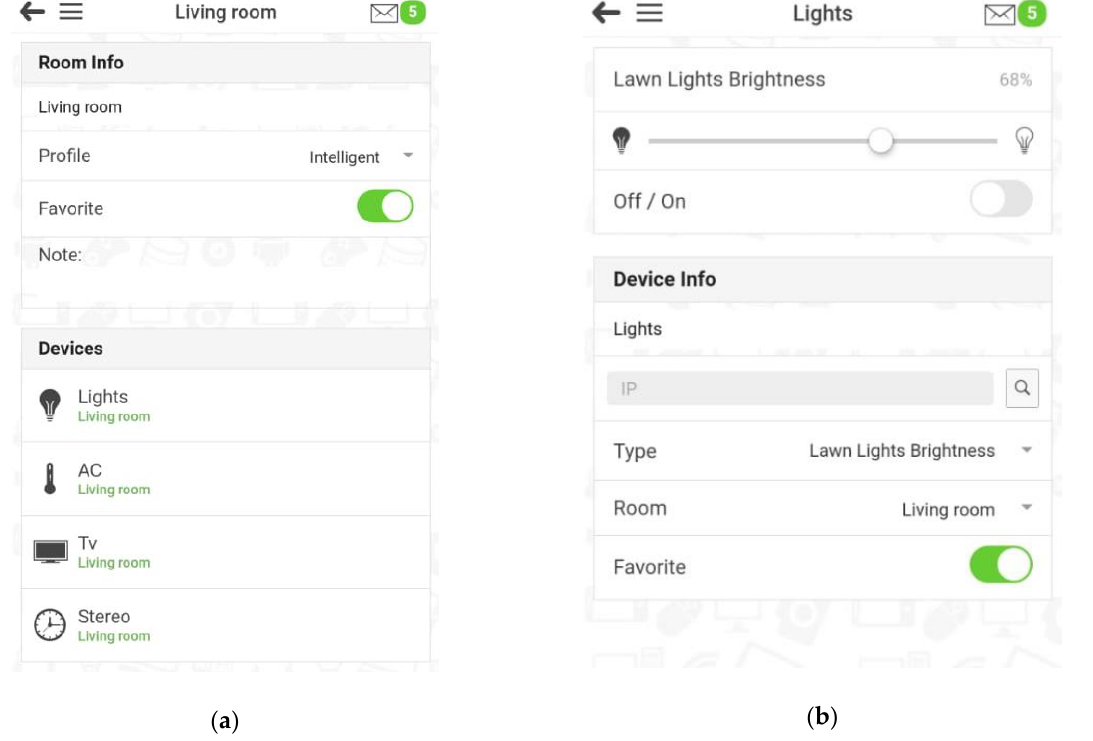
Figure 3. Manual configuration interfaces of the application: ( a ) room settings and its devices; and ( b ) device details and settings.